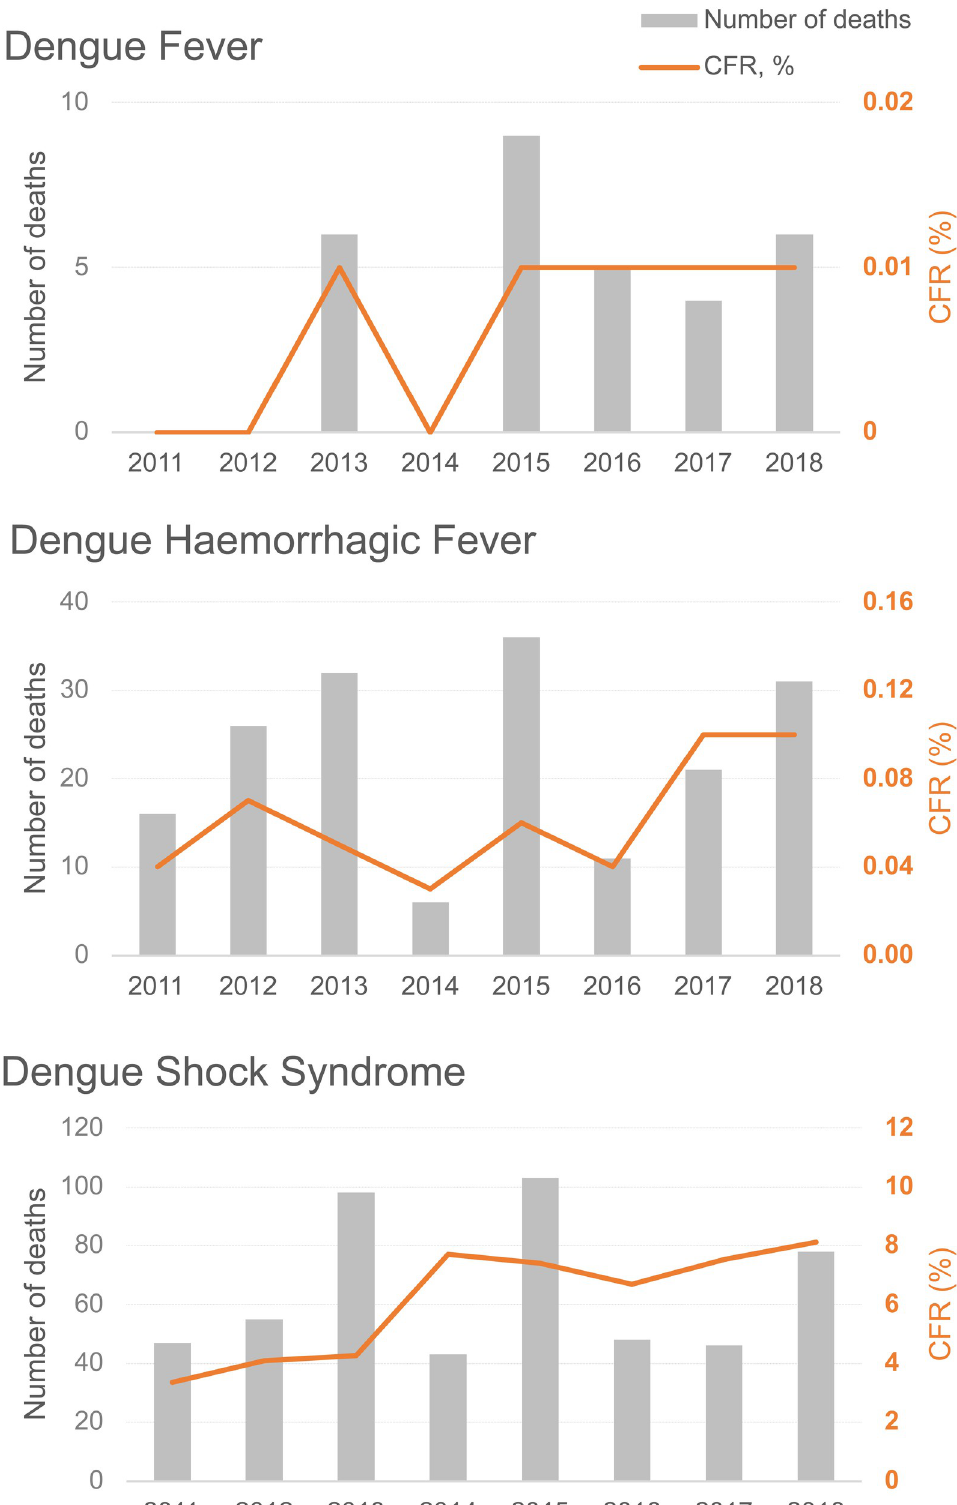
Fig 4. National number of deaths and CFRs by 1997 WHO case definition between 2011–2018; Source MoPH [12]. CFRs, case fatality rates. Note for dengue fever, no deaths were reported in 2011, 2012, and 2014.